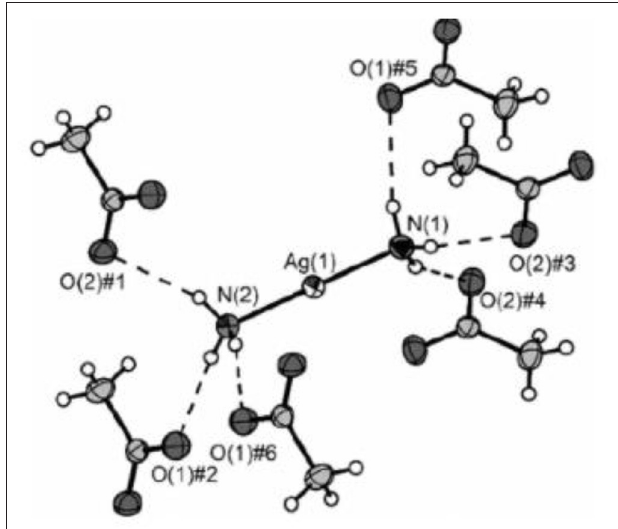
FIGURE 2 | X-ray crystal structure of diammine silver(I) acetate ([Ag(NH 3 ) 2 ]OAc), which has close to linear two-coordination of silver(I) by two ammonia (ammine) ligands. Reproduced from Ref. [ 22] with